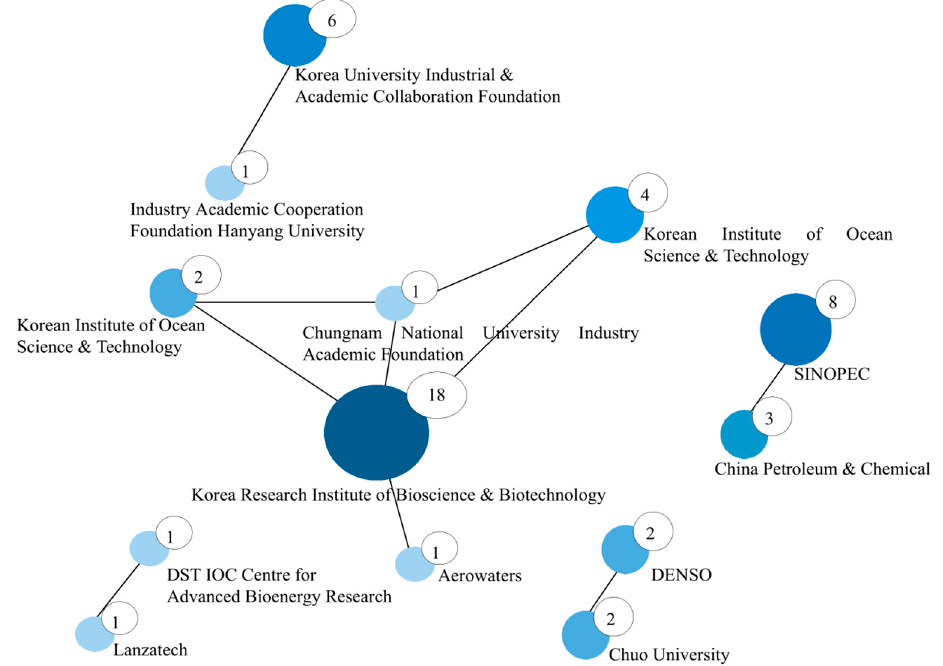
Figure 11. Interaction networks between the main depositors and their respective institutions. The numbers represent the quantity of interactions of the main depositors.